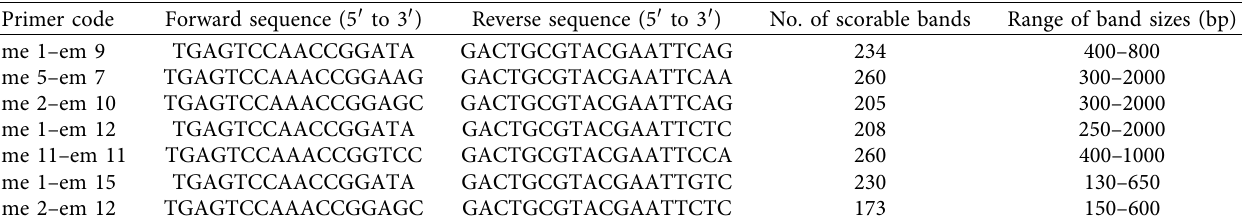
Table 4: Details of SRAP primer combinations showing the number and size of amplified fragments generated in tested plants. Primer